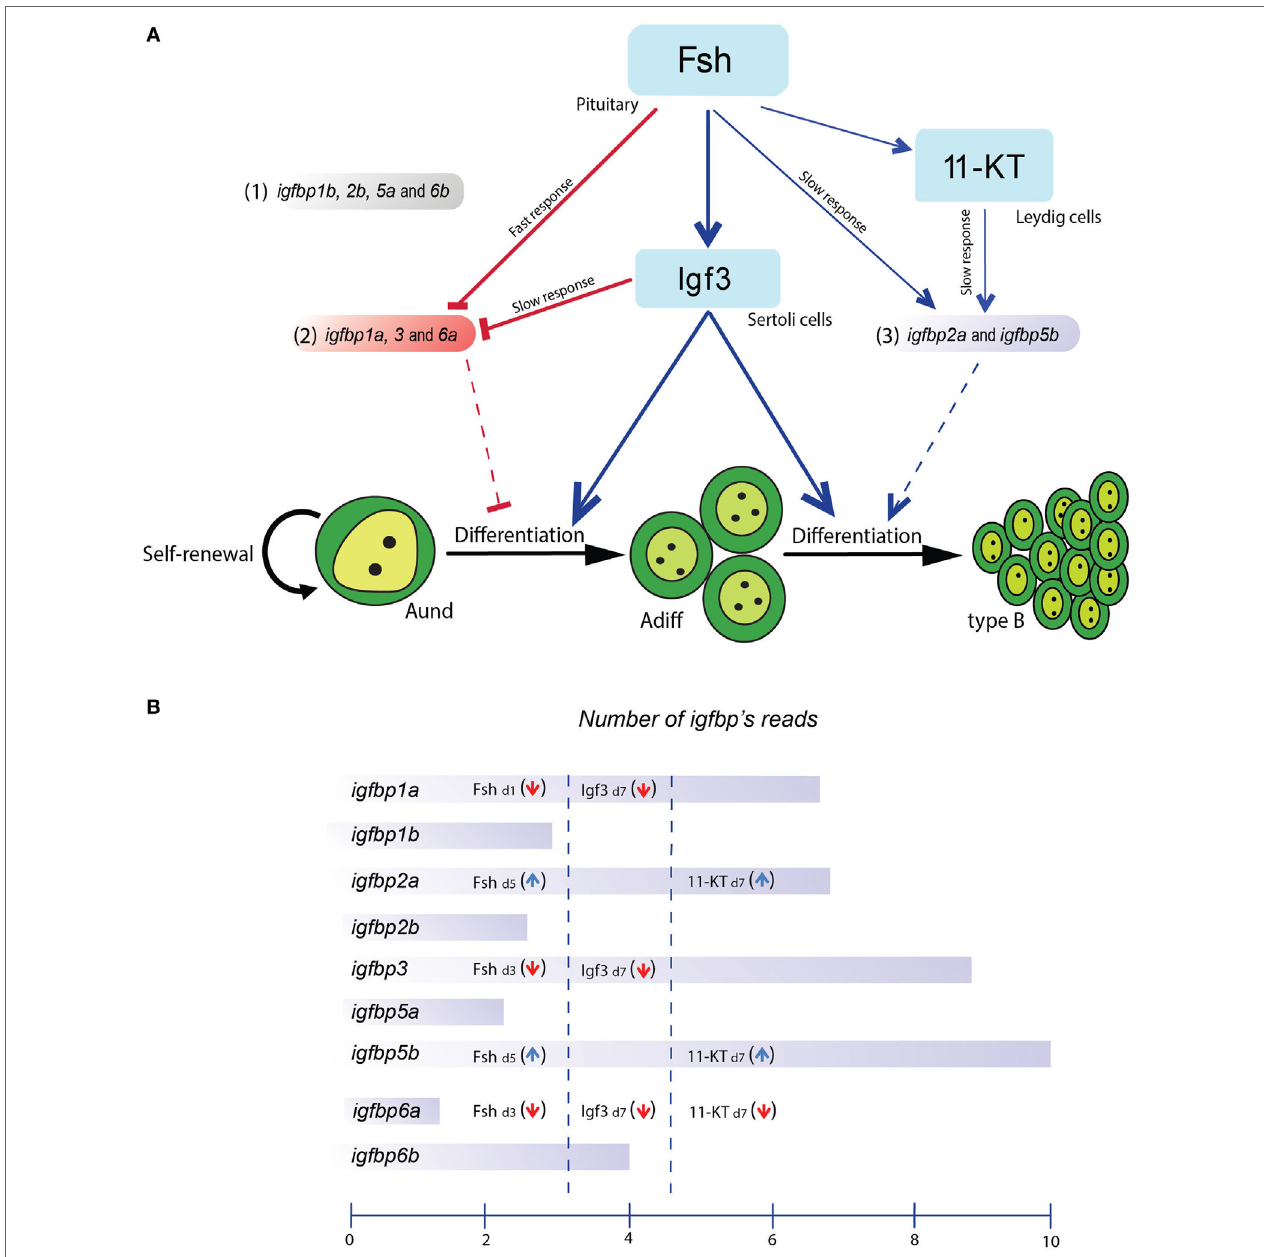
FigUre 7 | Schematic representation of the effects of follicle-stimulating hormone (Fsh) and two downstream mediators, Igf3 and 11-KT, on IGF-binding protein ( igfbp ) transcript levels and potential roles of Igfbps in adult zebrafish testis. (a) Fsh rapidly reduced transcript levels of subgroup 2 (consisting of igfbp1a , -3 , and -6a ) and increased the expression/release of Igf3 and 11-ketotestosterone (11-KT). Igf3 also reduced the transcript levels of subgroup 2 members whereas those of subgroup 3 (consisting of igfbp1b , -2b , -5a , and -6b ) were increased by Fsh and 11-KT. The transcript levels of subgroup 1 (consisting of igfbp2a and -5b ) were not modulated in the present experiments. (b) Schematic representation of the igfbp transcript levels and their hormonal regulation in zebrafish testis tissue. The representation of the igfbp transcript amounts reflects read numbers from RNAseq data (Crespo, Bogerd, and Schulz, unpublished data) from 5 testes of normal adult males. The mean read numbers were transformed using the logarithm to the base 2, i.e., the scale covers a 1024-fold (2 10 ) difference in average read